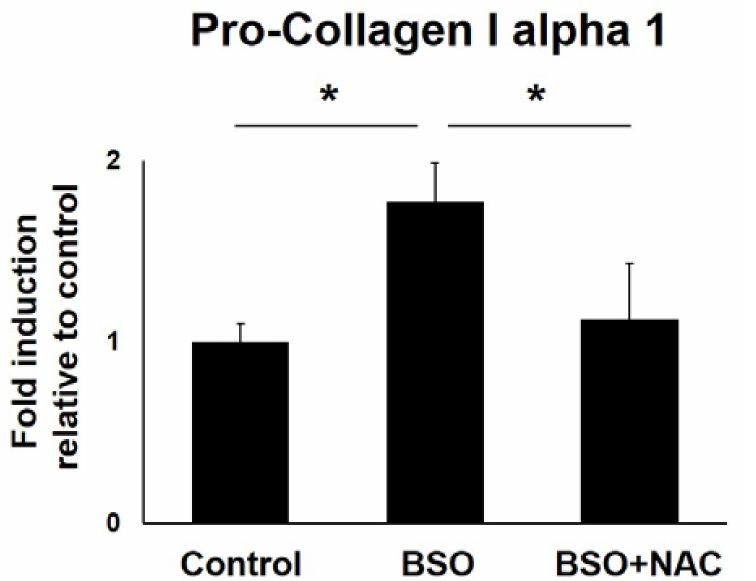
Figure 5. Enzyme-linked immunosorbent assay for quantitative pro-collagen I alpha 1 measurement in LF cell culture supernatants. Buthionine sulfoximine (BSO)-mediated induction of pro-collagen I alpha 1 was significantly reduced with N-acetylcysteine (NAC) treatment. These experiments were conducted independently in triplicate. The data are presented as the mean ± standard deviation. * <